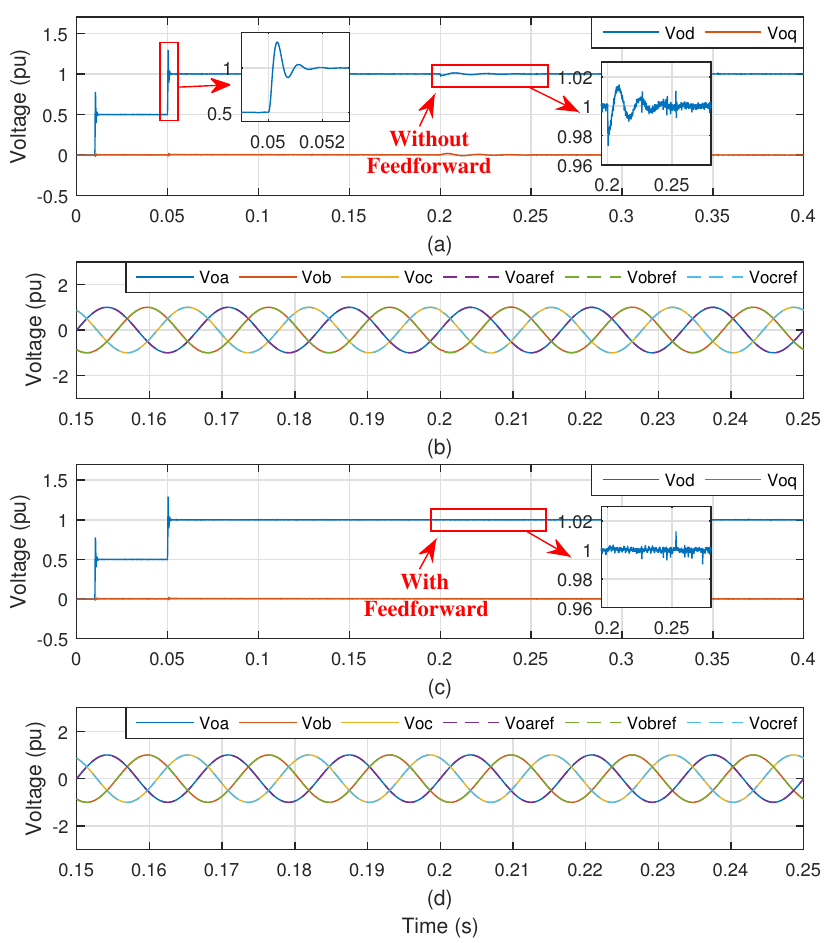
Figure 11. AC-AC 3 × 3 DMC operation with PI 4 ( s ) . ( a ) Output voltage in the dq reference frame without feedforward, ( b ) output voltage without feedforward, ( c ) output voltage in the dq reference frame with feedforward, and ( d ) output voltage with